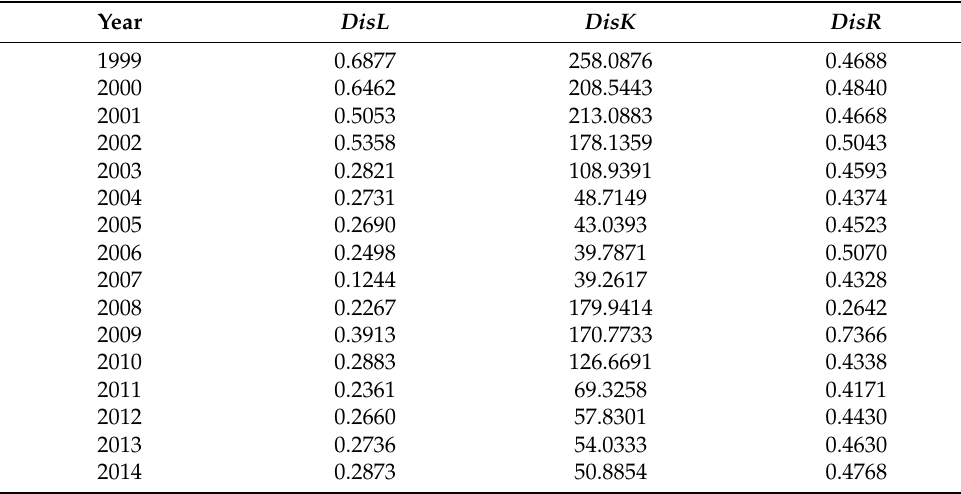
Table 1. Price Distortions of Various Factors in the Marine Fishery Industry from 1999 to